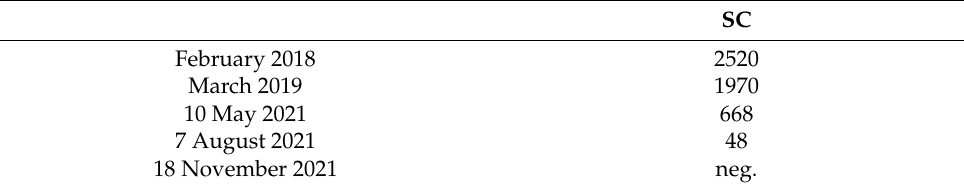
Table 4. Standing crops (SC) of macroalgae, expressed in tonnes wet weight (T WW ), present in the were calculated through the extension of mats by Fiji program (except November) and estimation of macroalgal biomass (b, in kg WW m − 2 ) was conducted in the field directly on the mats. neg., negligible. SC